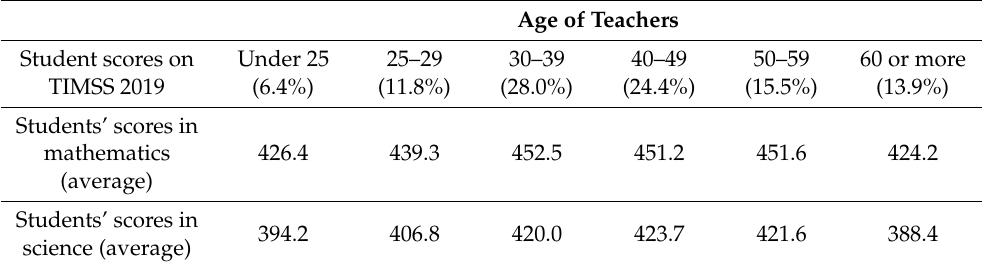
Table 2. Teachers’ calendar age compared to students’ TIMSS 2019 scores.